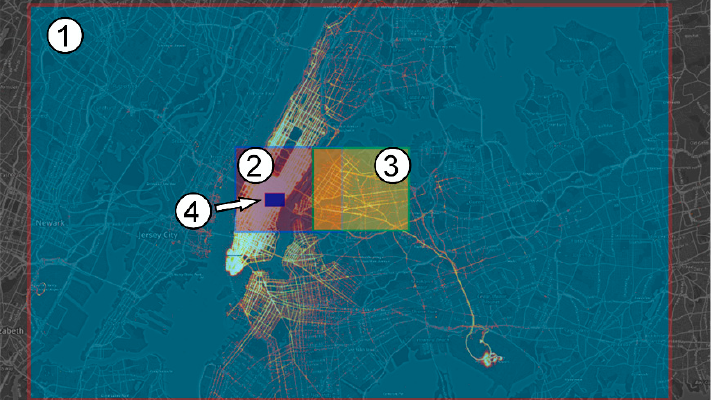
Figure 11. The different spatial extents for queries displayed on OpenStreetMap. Figure 11. The di ff erent spatial extents for queries displayed on OpenStreetMap.